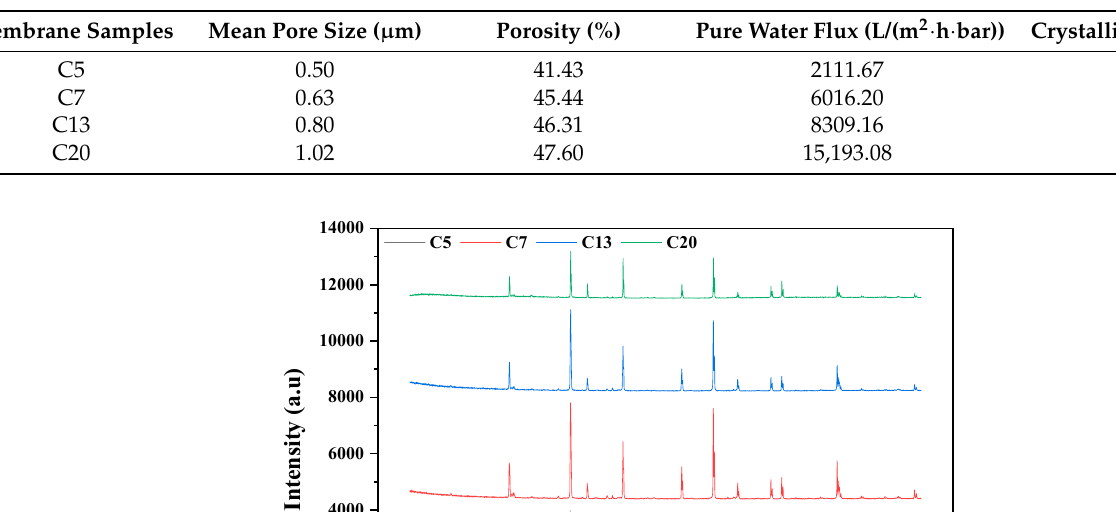
Table 1. Characteristics of the ceramic membranes.